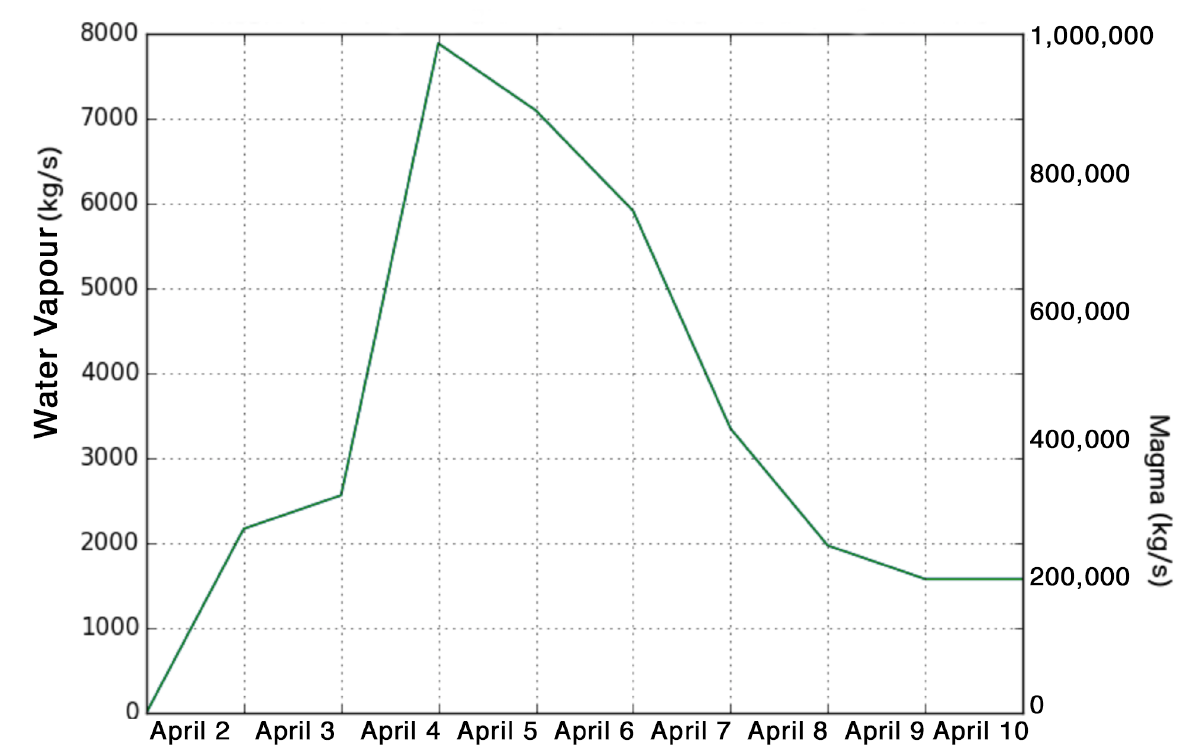
Figure 5. Emission of magma at the eruptive vent according to the authors of [40] and emission of water vapour from